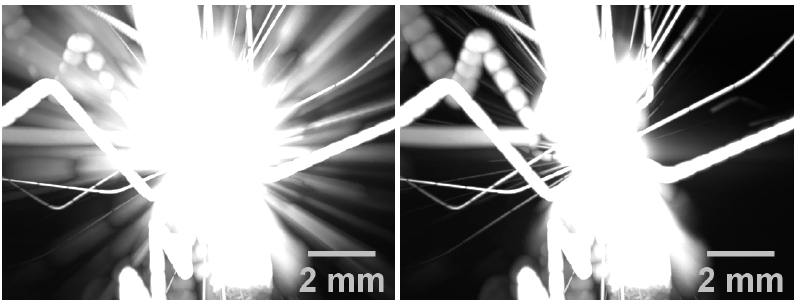
Figure 1. Summed image with and without